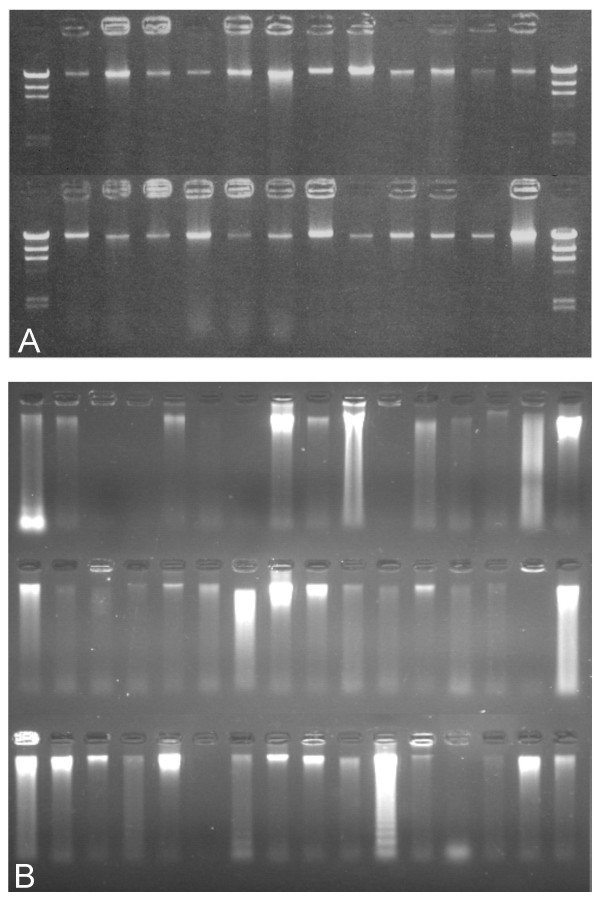
Electrophoretic aspect of enzymatically isolated DNA. A: Agarose gel electrophoresis of typical enzymatically isolated DNA from 24 different species (in the following order: Phlomis fructicosa, Humulus lupulus, Veratrum album, Scilla bifolia, Astragalus gummifer, Vitis vinifera, Centaurea macrocephala, Narcissus pseudonarcissus, Allium ampeloprassum, Salvia officinalis, Viburnum carlesii, Colchicum speciosum, Triticum turgidum, Polygonum chinensis, Lathyrus vernus, Tilia sp., Caragana sophorifolia, Urtica dioica, Lilium henryi, Polygonum multiflorus, Geranium sp., Lupinus sp., Crocus albiflorus, Helleborus dumetorum). After digestion, the DNA was isolated with Dynabeads® DNA DIRECT™ Universal magnetic beads. One fourth of the isolated DNA was loaded. The first and last lines were loaded with 250 ng of lambda/HindIII DNA (500 ng, bottom half, right). B: Agarose gel electrophoresis of DNA of 42 randomly chosen species (in the following order: Danae racemosa, Epimedium alpinum, Gladiolus palustris, Viburnum farreri, Euonymus bungeana, Weigela sp., Prunus padus, Rhodea japonica, Polygonatum multiflorum, Daphne japonica, Ribes petraeum, Asplenuim scolopendrium, Carex morrowii, Aruncus dioicus, Bletilla striata, Helleborus odoratus, Hedera helix, Brunnera macrophylla, Paeonia belladonna, Atropa belladonna, Solanum tuberosum, Beta vulgaris, Anethum graveolens, Allium fistulosum, Sison amomum, Uniola latifolia, Sinningia magnifica, Peperomia sp., Alnus sp., Tillia sp., Betula sp., Skimmia sp., Liriope spicata, Anthericum liliago, Inula ensifolia, Phlomis fruticosa, Lilium pumilum, Sorbaria sorbifolia, Dietes bicolor, Ilex aquifolium, Vitis vinifera, Setaria italica, Triticum aestivum, Nymphea sp., Pelargonium sp., Saintpaulia magungensis, Morinda sp., Zea mais). After enzymatic digestion in half of a 96 microtitration plate, DNA was isolated using Wizard® Magnetic 96 Plant System magnetic beads. One fourth of the isolated DNA was loaded.